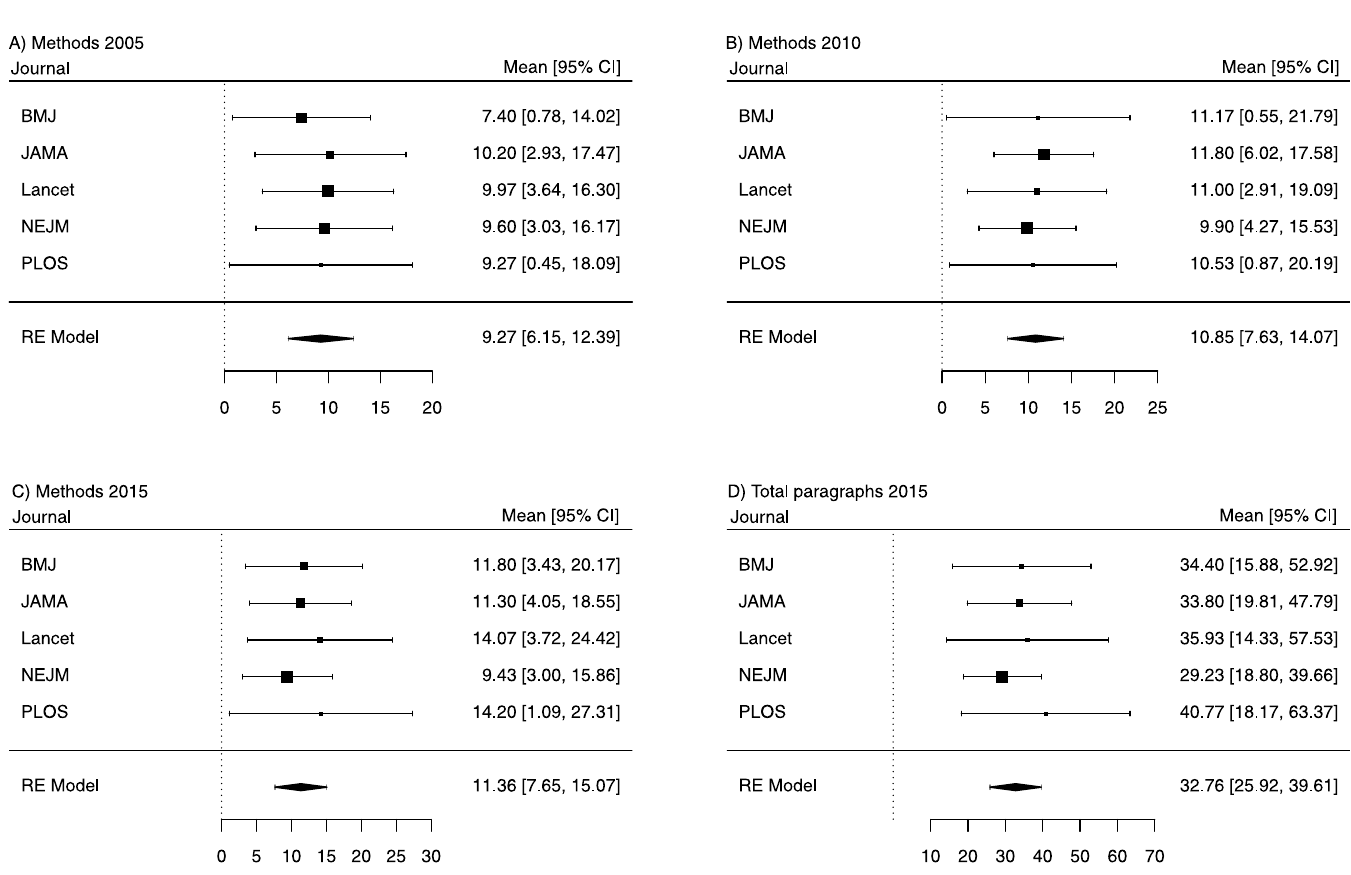
Fig 1. Forest plots from meta-analyses. Pooled means of number of paragraphs (black squares) and 95% confidence intervals (CI, lines) are displayed for each journal for A) methods section in 2005, B) methods section in 2010, C) methods section in 2015 and D) the total number of paragraphs in 2015, respectively. Summary statistics (black diamond) was calculated using the random effects DerSimonian & Laird approach [14]. BMJ: The BMJ, JAMA: The Journal of the American Medical Association, NEJM: The New England Journal of Medicine, PLOS: PLOS